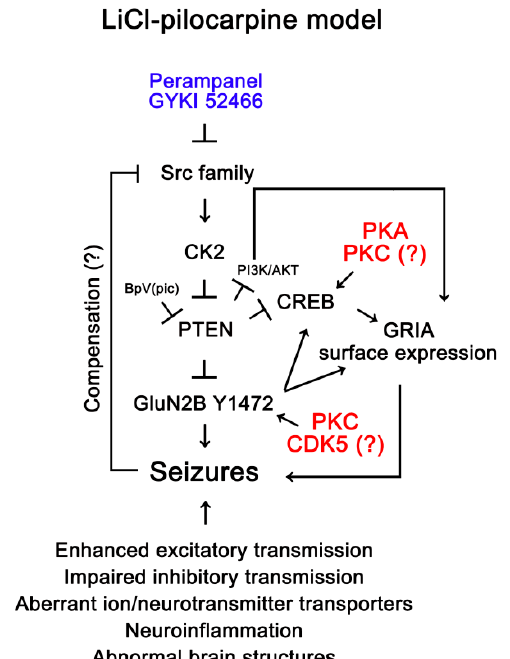
Figure 8. Scheme of the effects of AMPAR antagonists on spontaneous seizure activity in epilepsy rats based on a previous [35] and the present studies. In epilepsy rats, GluN2B Y1472 and CREB phosphorylations may be increased by multiple signaling pathways, such as protein kinase A (PKA), protein kinase C (PKC), and cyclin-dependent kinase 5 (CDK5). In addition, Src-CK2 axis may be inhibited as a compensatory response to the decreased PTEN expression via unknown mechanisms. However, this adaptive response may be insufficient to abrogate the hyper-phosphorylations of GluN2B and CREB. In responders, perampanel and GYKI 52,466 may further decrease Src-CK2 activity, which leads to increased PTEN activity (dephosphorylation) concomitant with its upregulation. Subsequently, the elevated PTEN activity may dephosphorylate GluN2B Y1472 and CREB S133 site that facilitate GRIA1 surface expression, concomitant with downregulation of phosphoinositide 3-kinase (PI3K)/AKT1 signaling pathway. These phenomena are not observed in non-responders and the dipotassium bisperoxovanadium(pic) dihydrate (BpV(pic), a PTEN inhibitor)-treated animals. Therefore, the present study demonstrates that this Src/CK2/PTEN-mediated GluN2B and CREB regulation may be required for the anti-epileptic effects of AMPAR antagonists.